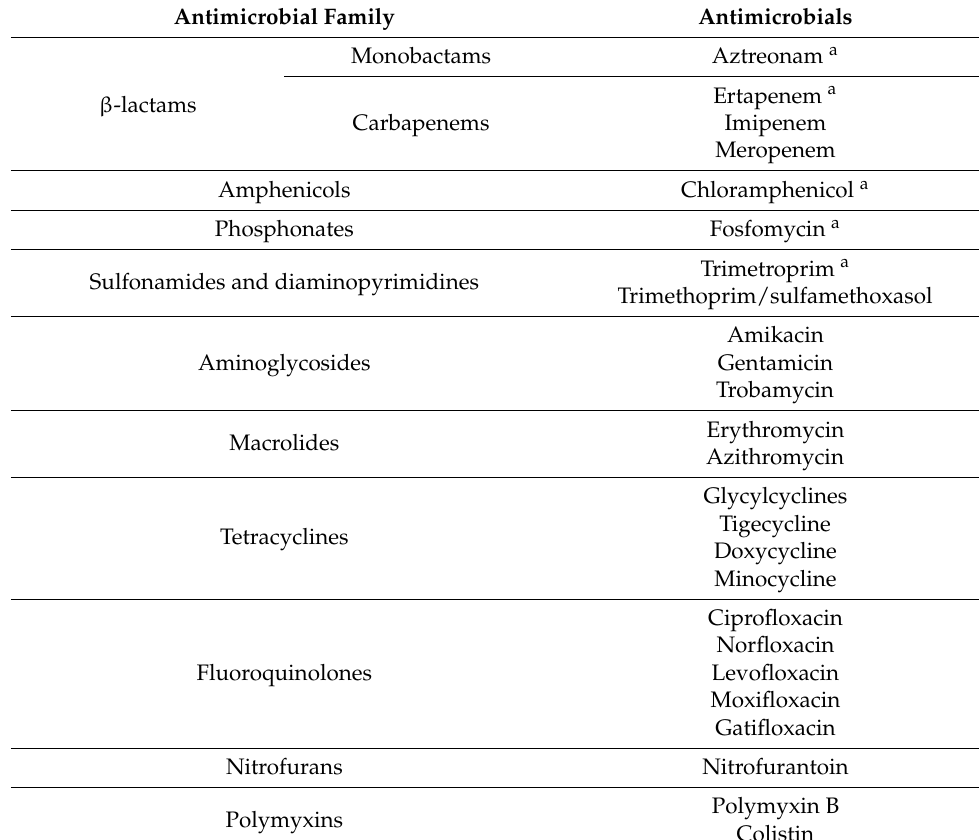
Table 1. Cont . Antimicrobial